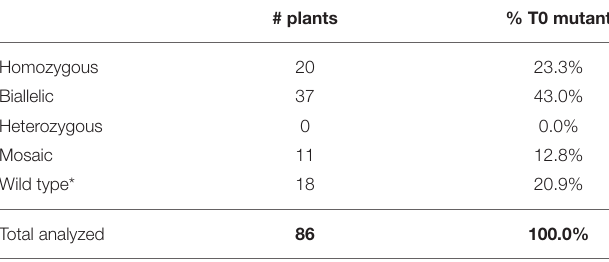
TABLE 2 | Summary of T0 mutant genotypes †